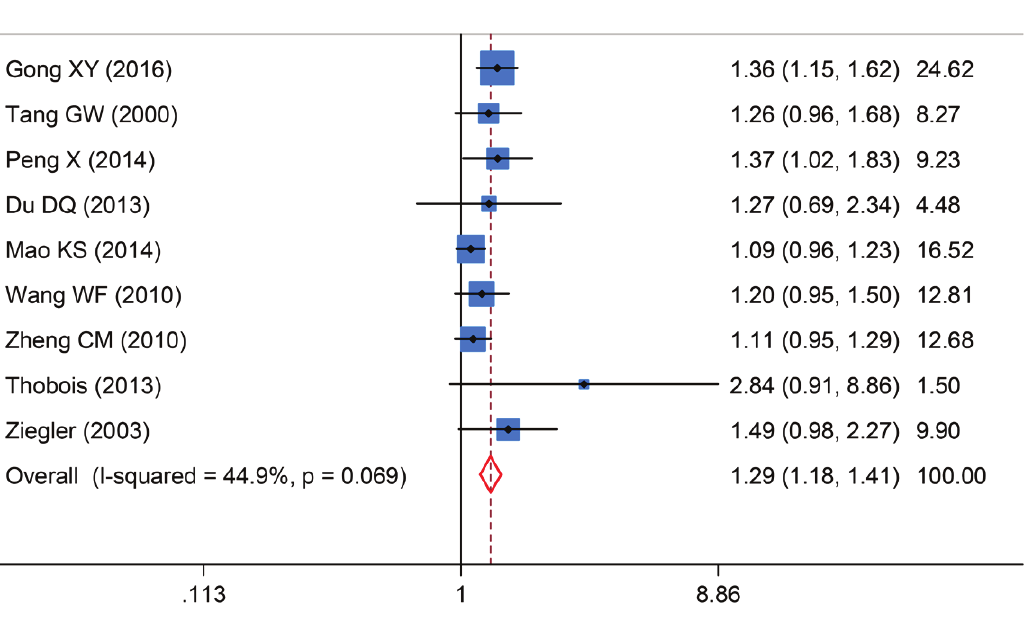
Figure 2: Forrest plot of clinical efficacy for piribedil in adjuvant treatment of Parkinson’s